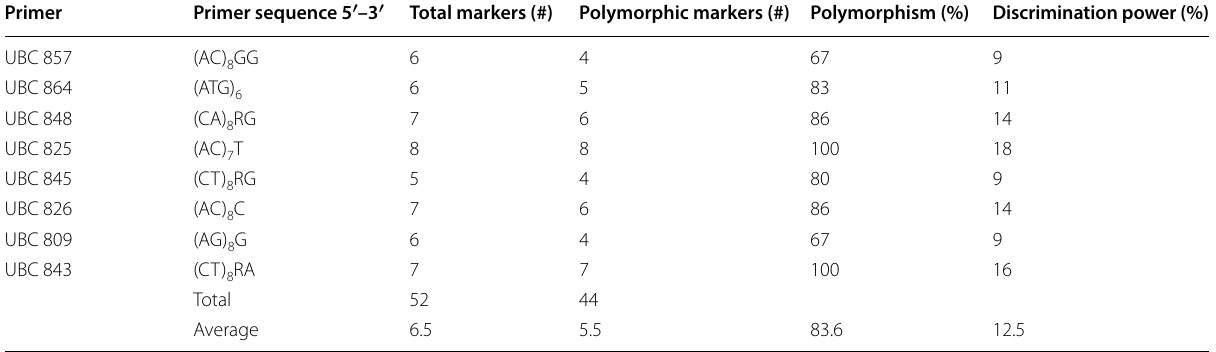
Table 2 ISSR primers names and sequences, total number of markers, primer efficiency, polymorphic markers, polymorphism, and discrimination